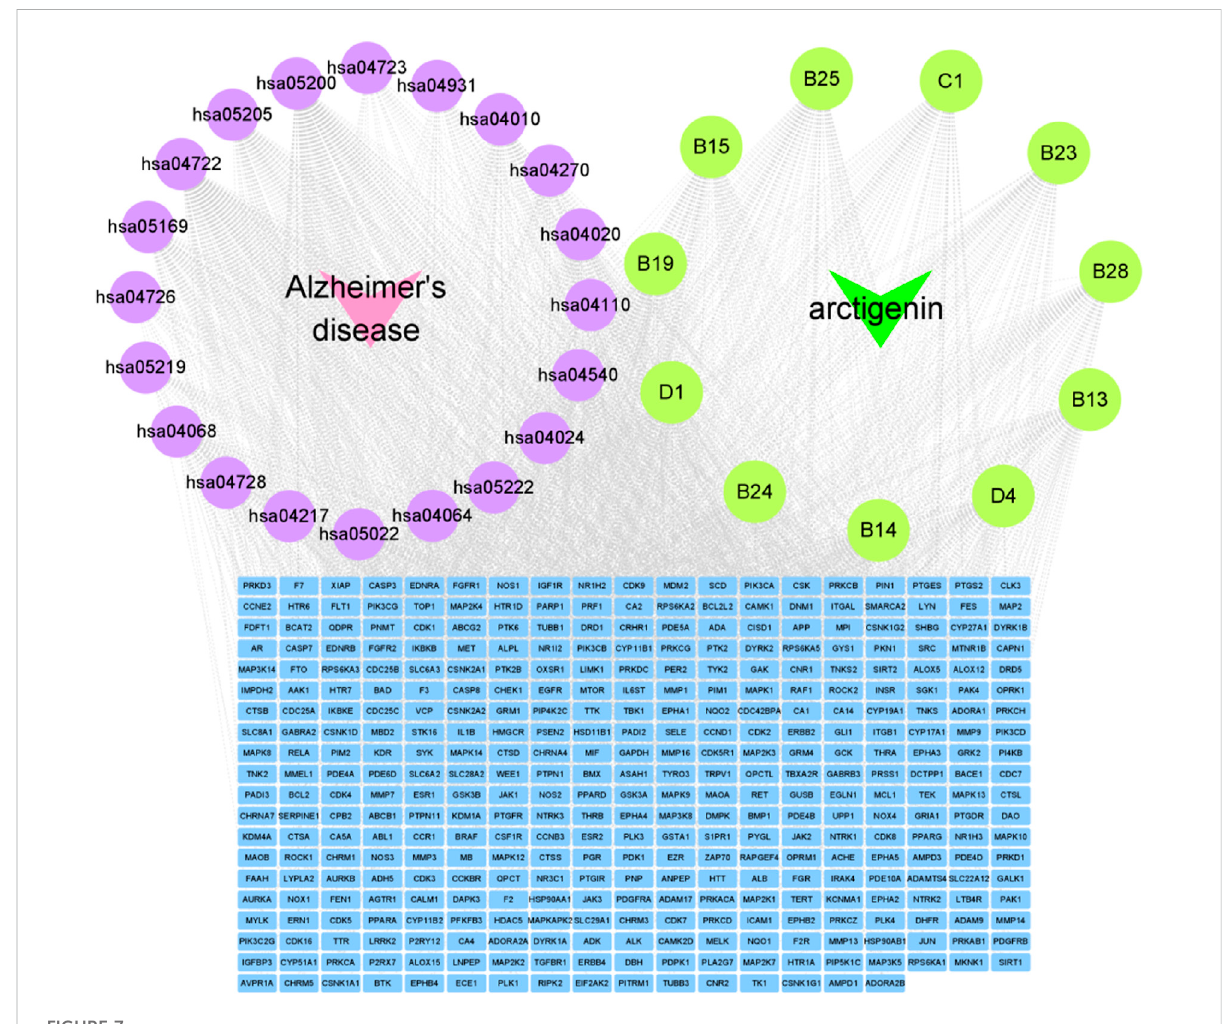
FIGURE 7 Cytoscape Network diagram (Disease-Pathway-Target-Metabolites